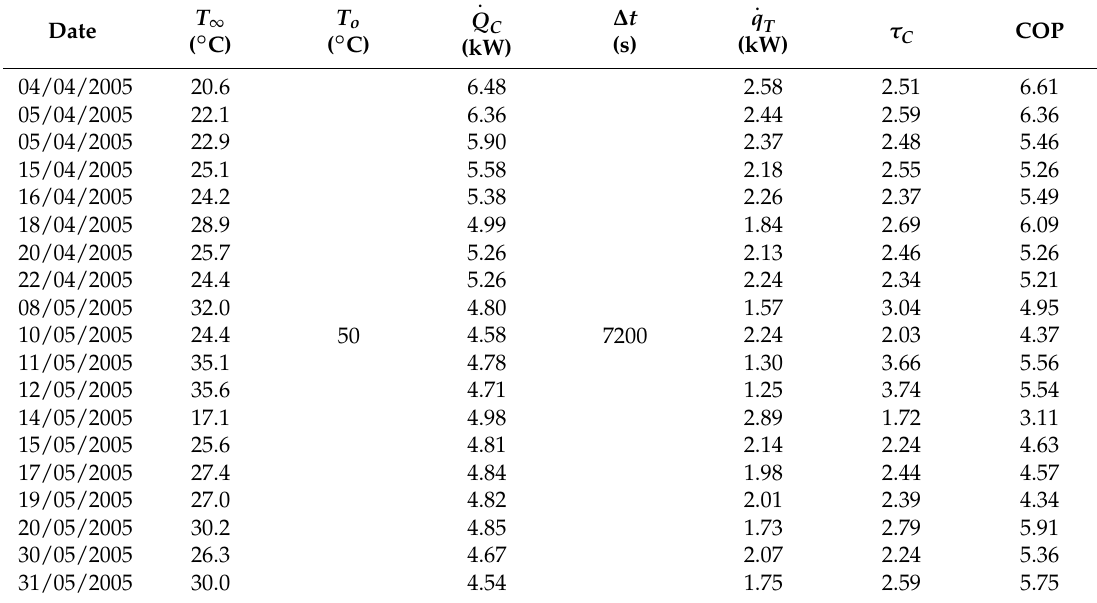
Table 4. Comparison with experimental data provided by Li et al. [52].